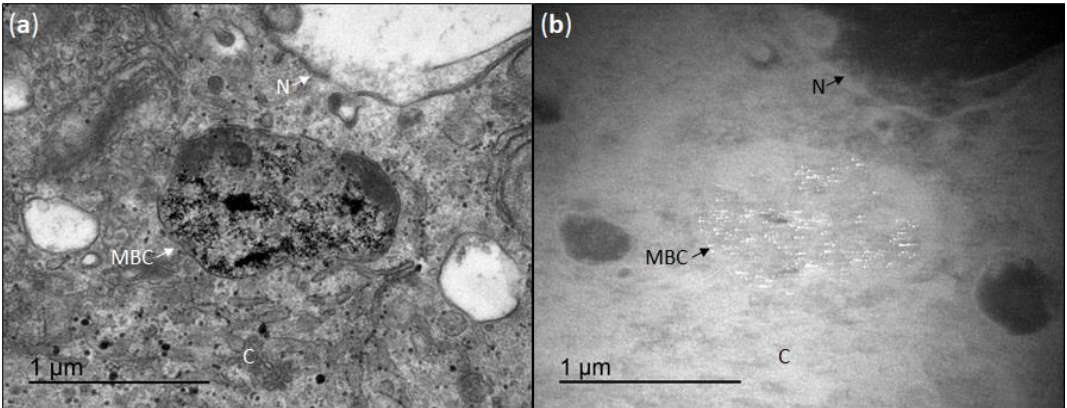
Figure 1. CeO 2 NPs characterization. ( a ) Transmission electron microscopy (TEM) and high-resolution transmission electron microscopy (HR-TEM) (inset) showing the as-synthesized cerium oxide (CeO 2 ) nanocrystals of 4 ± 1 nm; ( b ) UV-VIS spectroscopy of CeO 2 NPs after conjugation to Human Serum Albumin (HSA) (CeO 2 NPs@HSA) and the same nanoparticles (NPs) after 48 h in model physiological media (DMEM + Fetal Bovine Serum at 10% v / v). The similar spectra through time shows the stability in the physiological media of the NPs used; ( c ) Dynamic light scattering (DLS) of CeO 2 NPs as synthesized, HSA, and CeO 2 NPs@HSA. While the spectrum of CeO 2 NPs shows a large presence of agglomerated NPs, the similar spectra of HSA and CeO 2 NPs@HSA rules out the presence of CeO 2 aggregates. Note, that all samples have been purified before measurement.